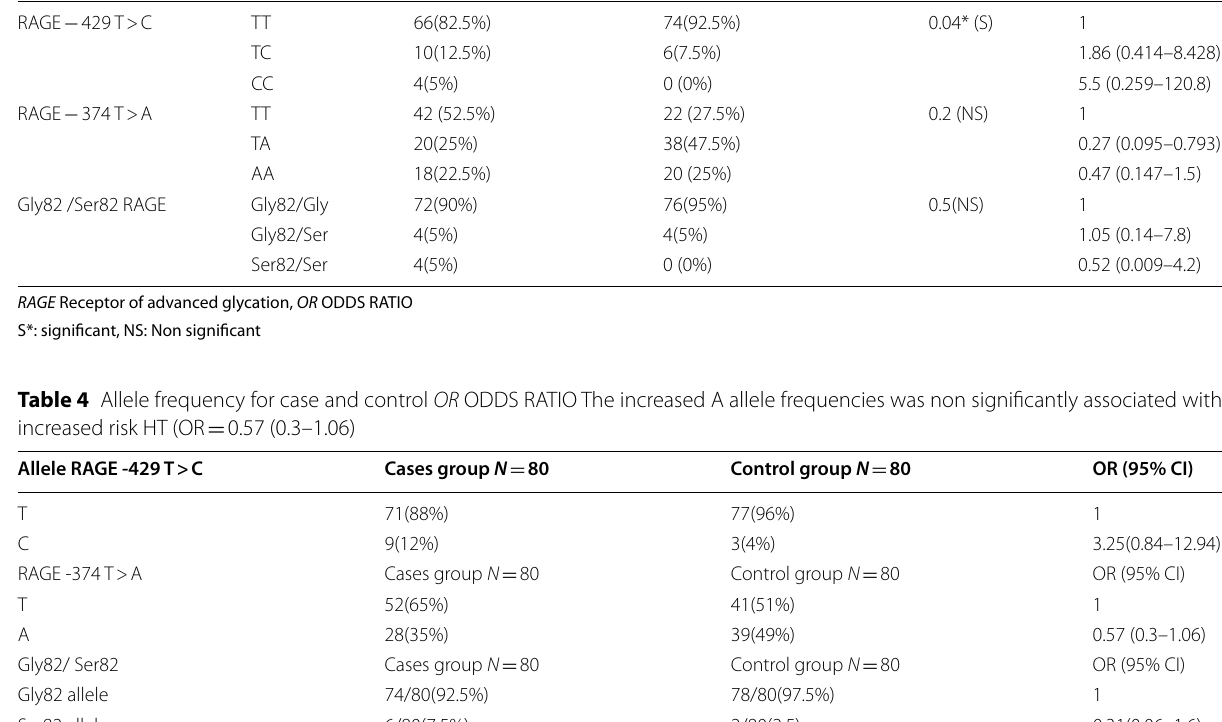
429 T > C and 374 T > A) and Gly82/Ser: shows a significant difference − −